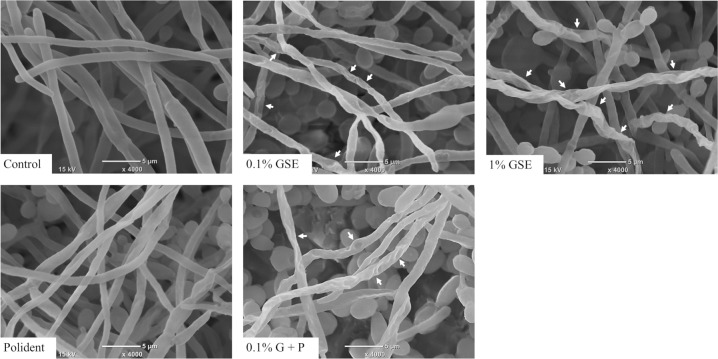
SEM images of the hyphae forms inside C. albicans biofilms formed on representative denture-base resin disc surfaces from each group.White arrows indicate shrinkage and damage on cell surfaces, which were not seen in the control and Polident.